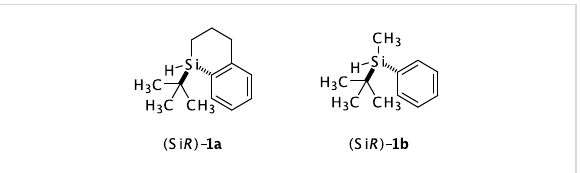
Figure 1: Cyclic and acyclic sterically encumbered